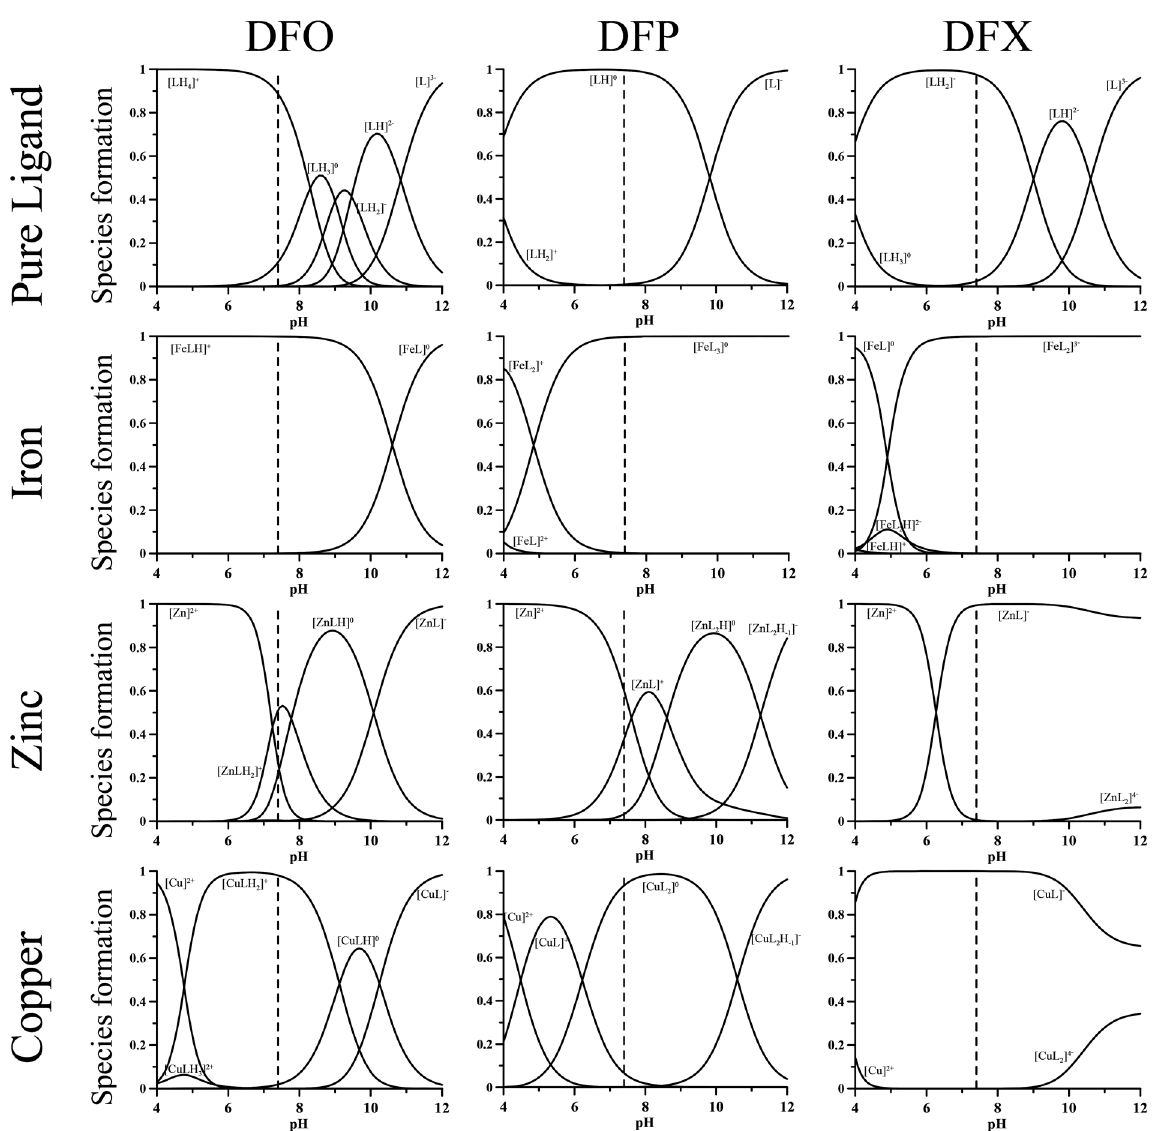
Fig 4. Speciation plots of the three ligands DFO, DFP and DFX and of their iron(III), copper(II) and zinc(II) complexes. Ligand concentration: 10 μ mol/ L; metal concentration: 1 μ